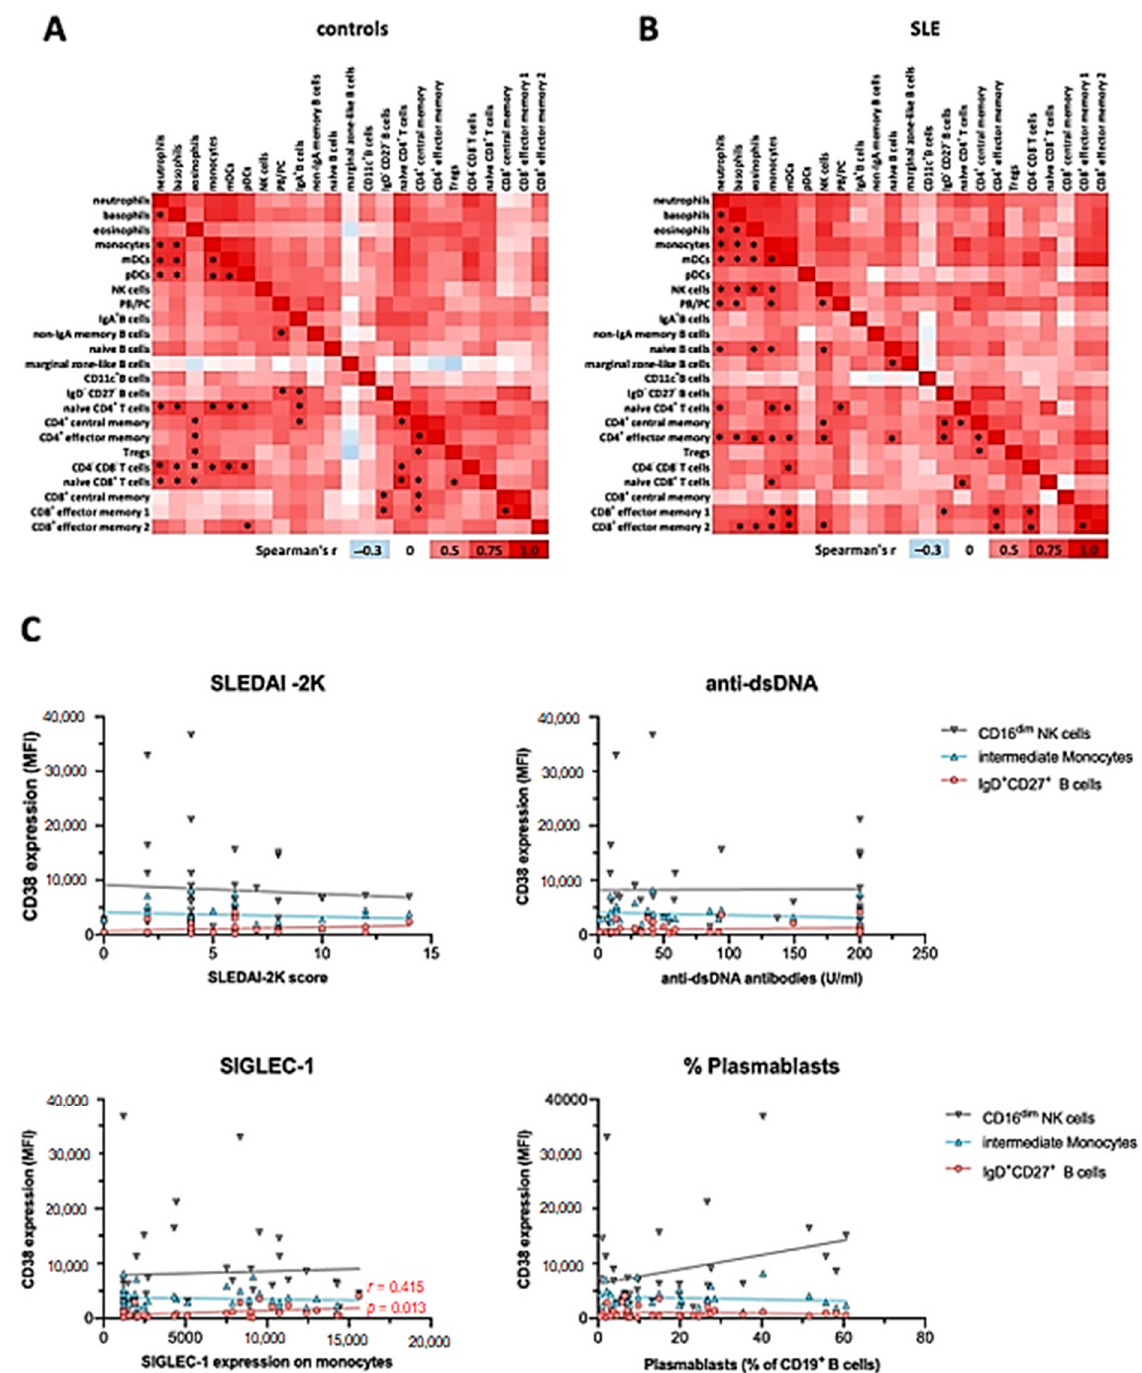
Figure 5. Correlation of CD38 expression levels across major immune cell subsets and with clinical activity. Mean CD38 SI values of immune cell subsets identified in Figures 1–3 were analyzed using Spearman correlation. Red color indicates positive correlation ( r > 0), white indicates no correlation ( r = 0), and blue color indicates negative correlation ( r < 0). * indicates significant correlations with a p value of < 0.001. ( A ) Data of 20 healthy controls. ( B ) Data of 20 SLE patients. ( C ) Spearman correlation of the disease activity score SLEDAI-2K, the immunological disease activity markers dsDNA antibody levels, SIGLEC-1 expression on monocytes, and the percentage of plasmablasts among CD19 + B cells with the CD38 expression on CD16 low NK cells, CD14 ++ CD16 + monocytes, and IgD + CD27 + B cells, based on the flow cytometric analysis of 36 SLE patients.